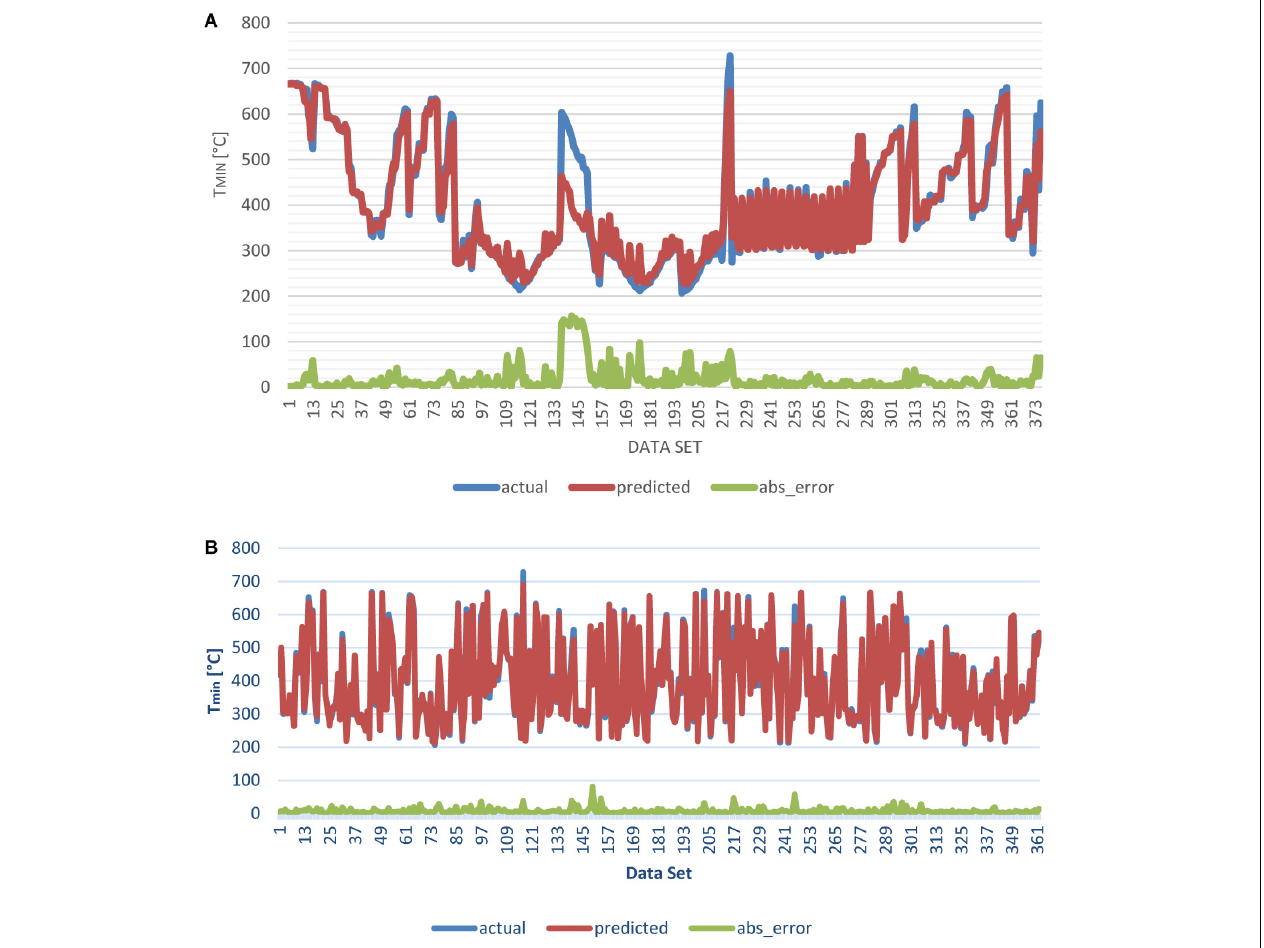
FIGURE 3 | (A) Prediction vs. actual for the full data sample set with absolute error plotted at the bottom of the graph. (B) Prediction vs. actual for the data sample set after removing outliers and applying data reshuffling. Absolute error is shown at the bottom of the graph.